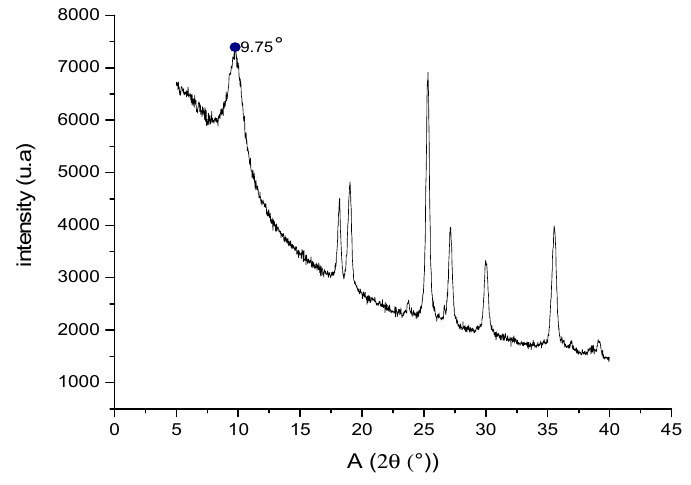
Figure 2. X-ray diffractogram of the GO synthesized in our study.